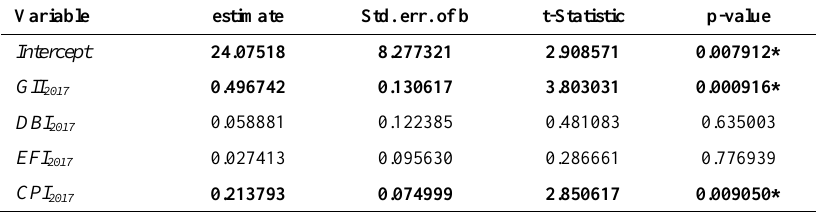
Table 6. The statistical output of the estimated variables for GCI score in 2017 Variable